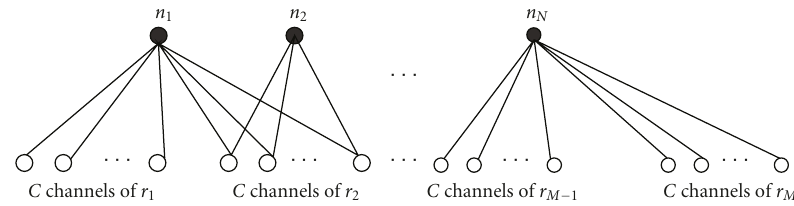
Figure 5: The bipartite graph example showing the association relationship between MNs and